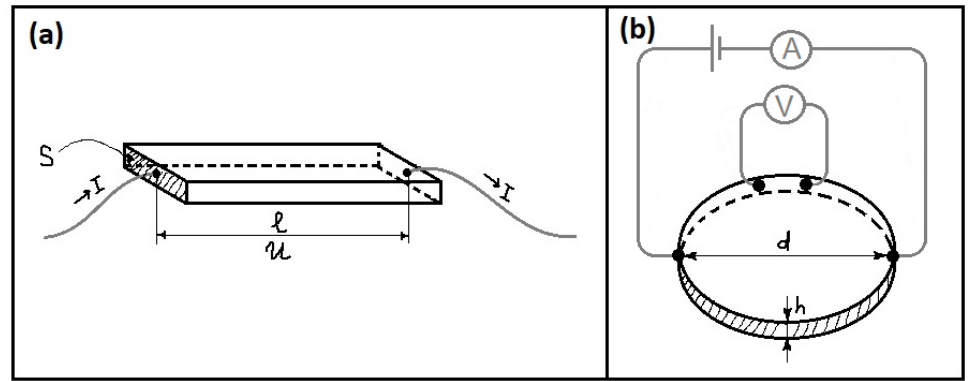
Figure 23. Schematic representation of two types of resistivity measurements: ( a ) two-point (2T) probe; and ( b ) four-point (4T) probe methods.